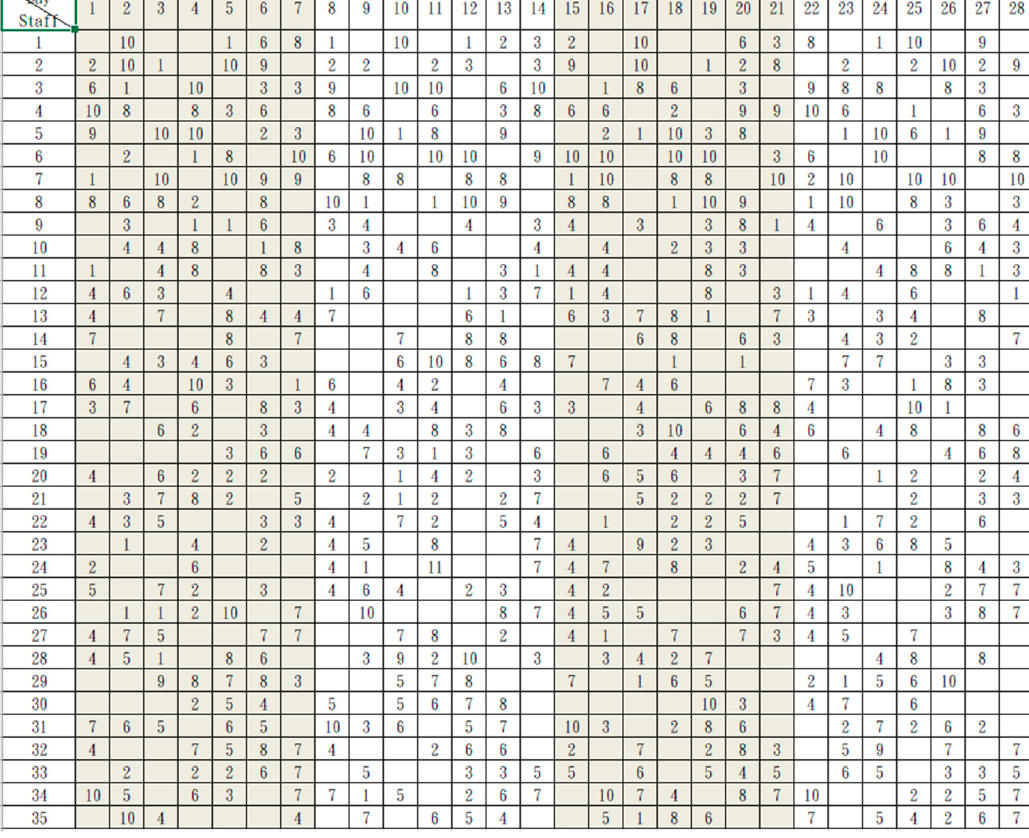
Figure 5. Daily schedule output.